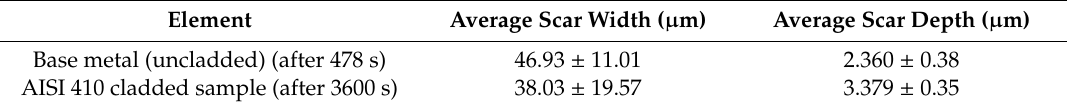
Table 5. Wear scar dimensions of base metal and cladded specimens.